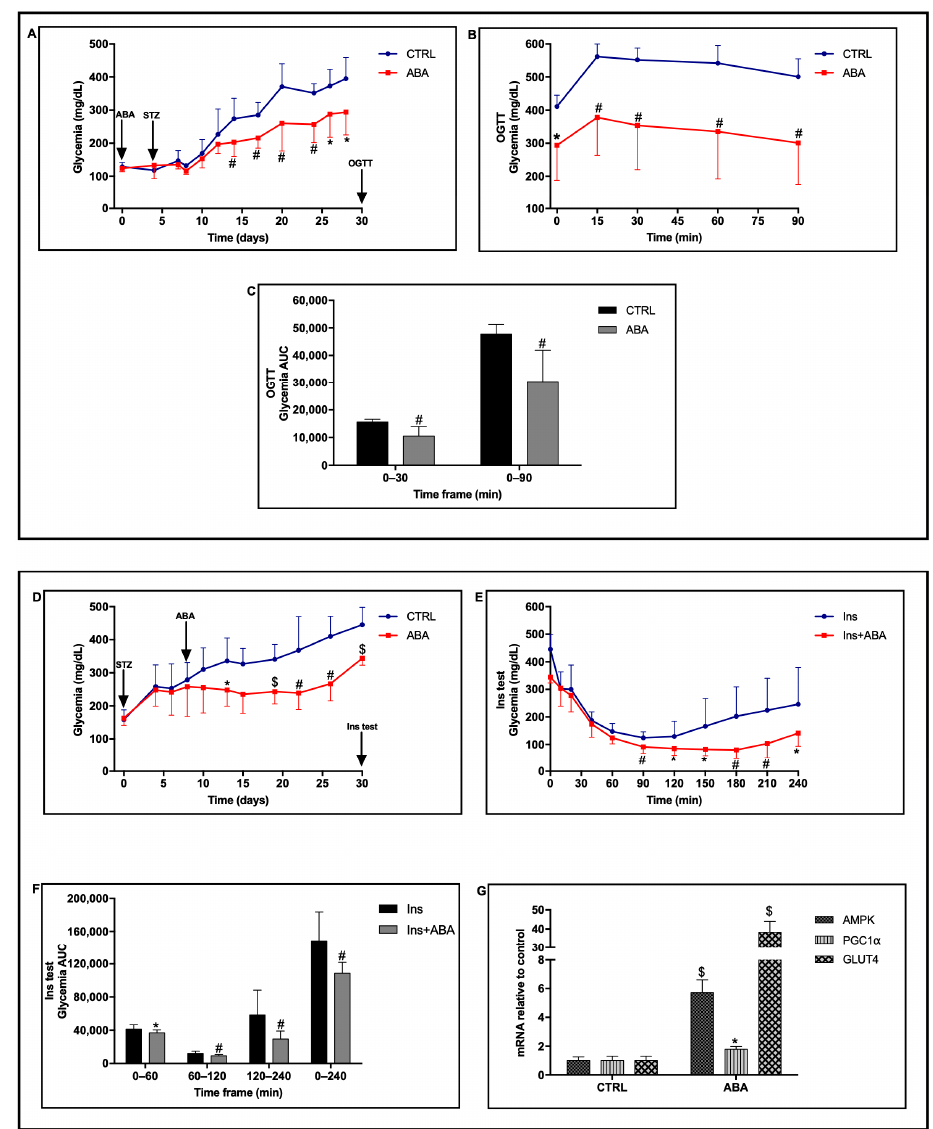
Figure 1. Chronic ABA treatment in a multiple low-dose STZ protocol reduces glycemia and improves glucose tolerance and the effect of exogenous insulin. Eight-week old male LANCL2+/+ (wild-type) mice, obtained from a heterozygous breeding scheme (see Materials and Methods) were divided into two groups (8 mice/group) and treated or not (control, CTRL) with ABA at 5 µ g/Kg BW/day starting either before (panels ( A – C )) or after (panels ( D – G )) diabetes induction with multiple low- dose streptozotocin (STZ) at 20 mg/Kg BW/day for 5 days. Upper panel: ( A ) glycemia profile over 30 days of control and of ABA-treated mice, ABA treatment starting at day 0 followed by STZ treatment starting at day 4 (arrows). ( B ) glycemia profile during the OGTT, performed at day 30 on the same animals with 0.25 g glucose/Kg BW, without (control) or with ABA (5 µ g/Kg BW). ( C ) AUC of the glycemia profile of the OGTT. Lower panel: ( D ) glycemia profile over 30 days of control and of ABA-treated mice, ABA treatment starting 3 days after completion of STZ treatment (arrows). ( E ) glycemia profile of the insulin test performed at day 30 with 0.1 U of insulin (Ins), injected s.c. at time zero. ( F ) AUC of the glycemia profile of the insulin test. ( G ) mRNA relative to control of AMPK, PGC-1 α and GLUT4 in the skeletal muscle from control and ABA-treated mice sacrificed 4 days after the insulin test. * p < 0.05, # p < 0.02 and $ p < 0.005 relative to CTRL or Ins. p values are calculated by unpaired two-tailed t